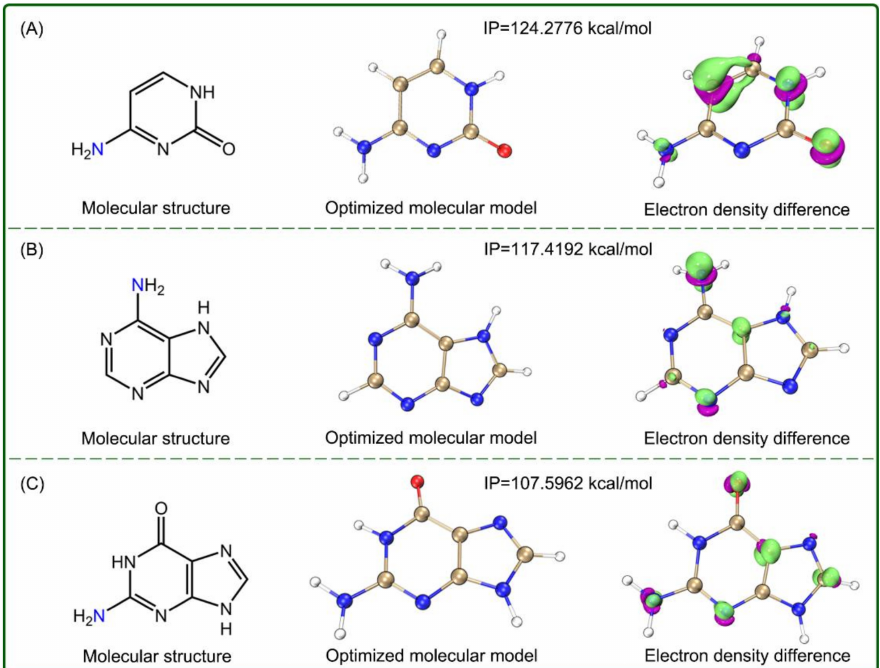
Figure 6. The structure, optimized molecular model along with IP value, and isosurface map of the electron density difference between the molecules and cationic radicals of three nucleobases in the aqueous SMD solvation model. A , cytosine; B , adenine; C , guanine. The calculations were based on M06-2X-D3/6–311+G** and M06-2X-D3/def2-TZVPD calculation levels. In the isosurface map, lime and purple colors correspond to the regions where the electron density increased and decreased, respectively (isovalue = 0.01). The Cartesian coordinates and energies of the optimized neutral molecules are listed in Supplementary Material